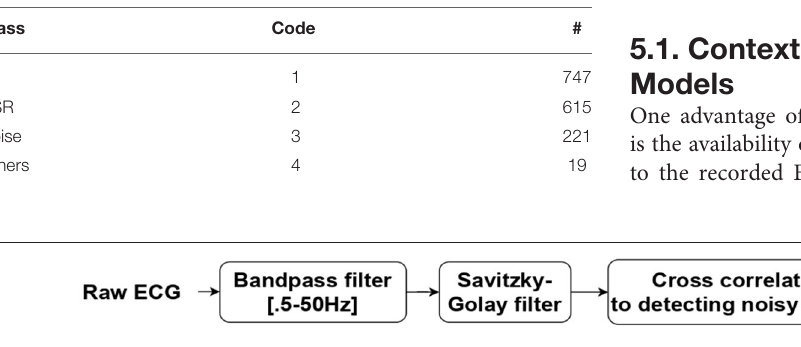
TABLE 7 | ECG annotation overview showing the class of rhythm types, its code in the annotation.csv file, and the number of available annotations for each class.